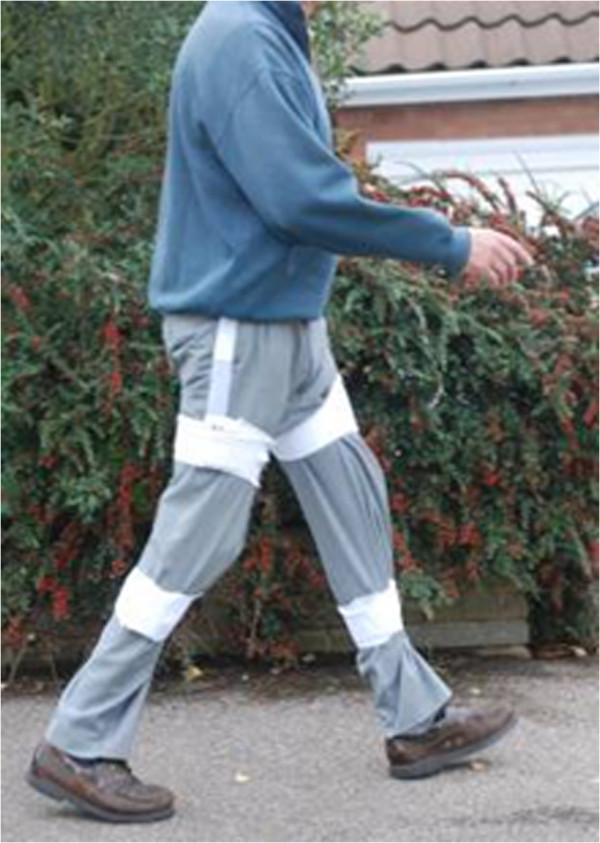
Volunteer walking with the IMUs strapped to the thigh and shank.